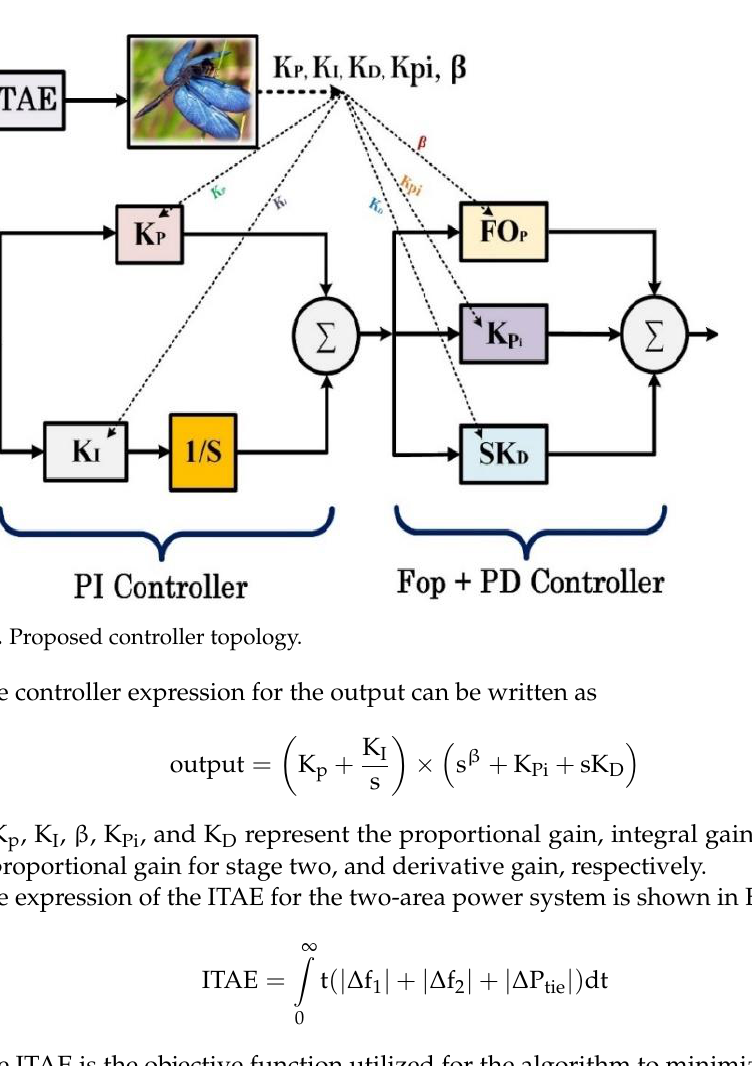
6 of 16 Figure 2 . Model under study . 3. Proposed Cascaded Design The proposed cascade structure proportional integral combined with fractional operator sums with proportional derivative (PI-(F O P +PD)) is showcased in Figure 3. The design is an advanced form of (PI-(1+PD)) that modifies the (1+PD) part of the cascaded